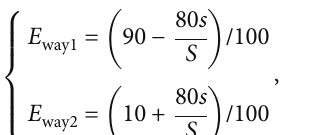
Figure 3: Applications of facial recognition algorithm with a better e ff ect on improving the ROI-KNN convolutional neural network.